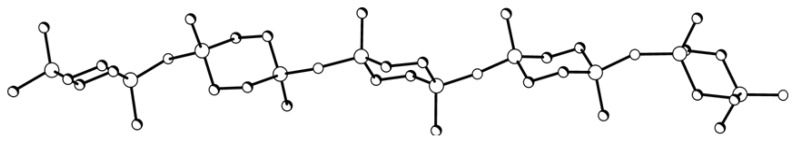
The most probable chain conformation of CL PMCS XI determined by the molecular mechanics method.